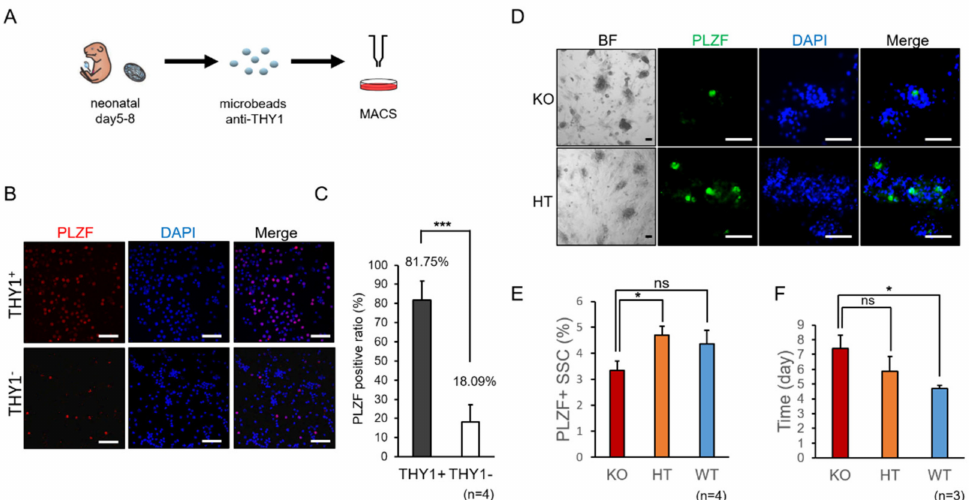
Figure 1. Deficiency of SMN in SSC maintenance in mice. ( A ) Graphic flow chart of SSC isolation. Testis cells for SSCs in vitro culture are obtained from male neonatal pups fractionated by magnetic-activated cell sorting (MACS) with magnetic microbeads conjugated to anti-THY1 (CD 90.2) antibody. ( B , C ) Detection of SSC marker PLZF in fractionated SSCs by immunofluorescent staining. 81.75% of PLZF positive cells (red color) is detected in THY1 + cells. DAPI is used for DNA stain (blue color). In contrast, fewer (18.09%) THY1 − cells presented PLZF ( n = 3). Scale bar: 200 µ m. t -test analysis is performed and significant differences is shown (*** p < 0.001). ( D ) PLZF expression in SSCs from SMA-like mice after in vitro culture. Bright field (BF) shows the morphology of SSC culture in mouse Smn1 knockout (KO) and heterozygous littermate control (HT) group. The KO SSCs express less PLZF protein (green color) compared with the HT control. DAPI used for nuclei stain is showed as blue color. Scale bar: 100 µ m. ( E ) The percentage of expressing PLZF is quantified in SSCs from KO, HT and wild-type (WT) SMA littermate mice. * Indicates a statistically significant difference, p < 0.05. ns indicates no